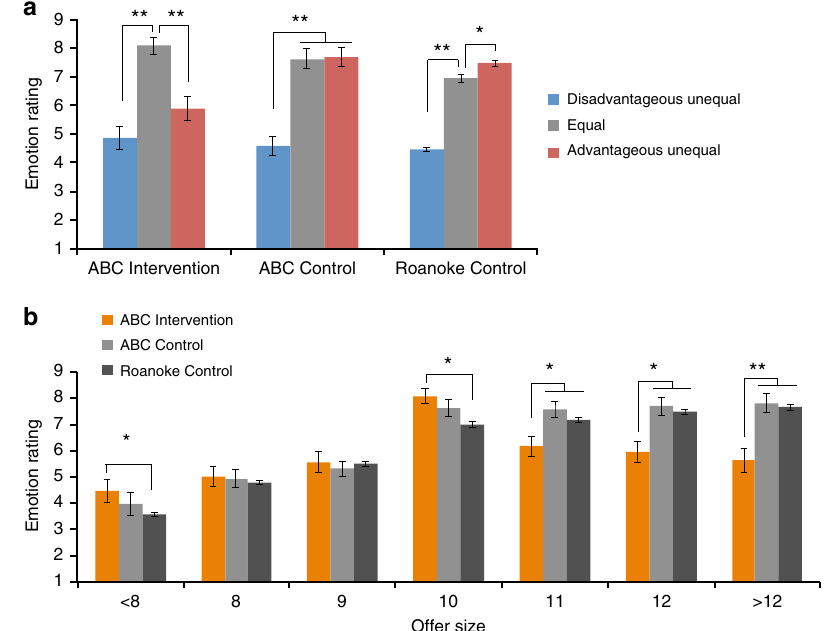
Fig. 3 Emotion rating across 60 rounds in Medium-High-Medium (MHM) type in the ultimatum game. a Emotion rating for MHM grouped by level of equality. ABC Interventions rated equal offers as more pleasant than both disadvantageous and advantageous offers. ABC Controls rated disadvantageous offers as less pleasant than equal offers but did not report different feelings about equal and advantageous offers. Roanoke Controls rated disadvantageous offers as less pleasant than equal offers but advantageous offers as more pleasant than equal offers. b Emotion rating across 60 rounds in MHM grouped by offer size. ABC Interventions rated equal offer as more pleasant than each disadvantageous offer as well as than each advantageous unequal offer, while ABC Controls decreased emotion rating for more disadvantageous offers but reported no difference between equal and advantageous offers. Compared with ABC Controls and Roanoke Controls, ABC Interventions rated each advantageous offer as signi fi cantly less pleasant. *p < 0.05, ** p < 0.001 (post hoc t- test p -values). Error bar represents s.e.m.